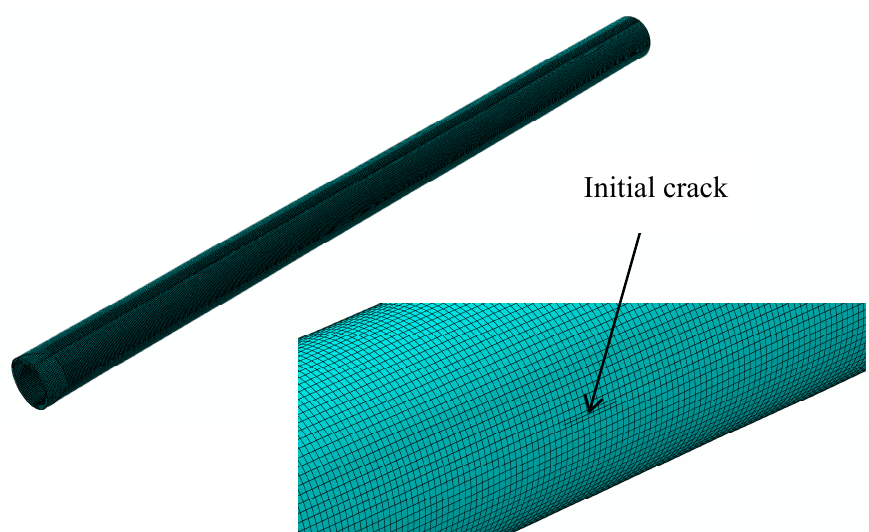
Figure 7. Finite element model of a hydraulic pipe and an enlargement of the initial crack section.